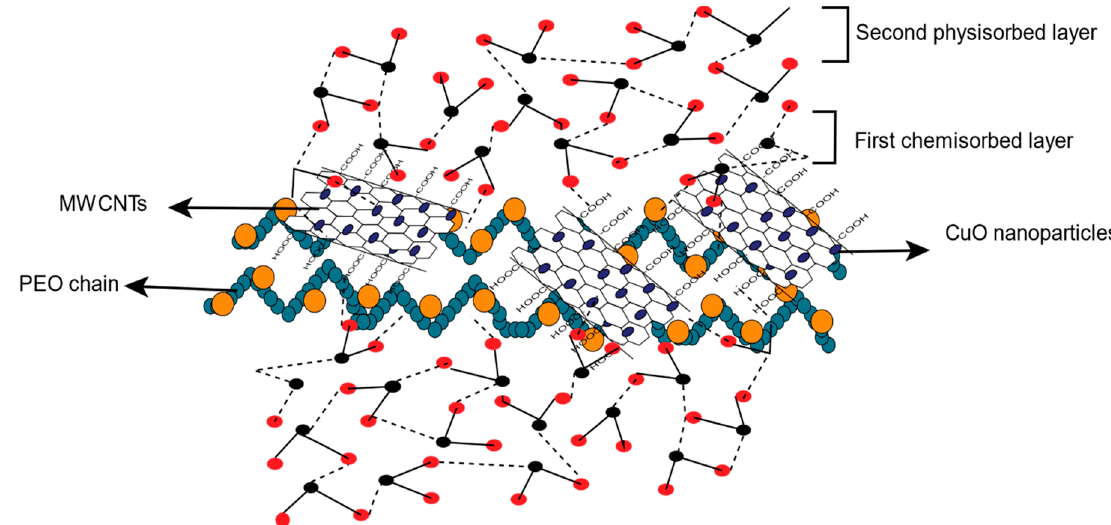
Figure 11. Schematic presentation of adsorption of H 2 O molecules on the surface of PEO − MWCNT − CuO nanocomposites.